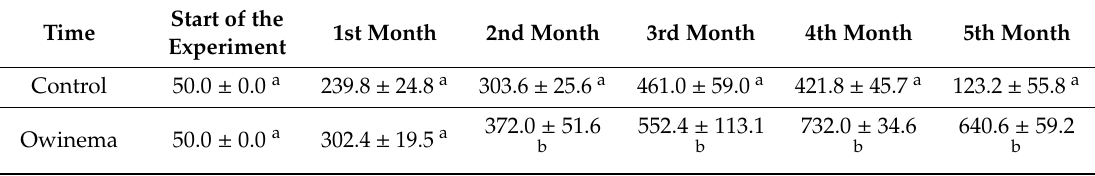
Table 2. Mean number of E. fetida individuals (ind ∙ container − 1 ± SD) in experimental “ecological boxes” depending on the presence of an Owinema bio-preparation (50 mln larvae m − 2 ) during a 5 month experiment.